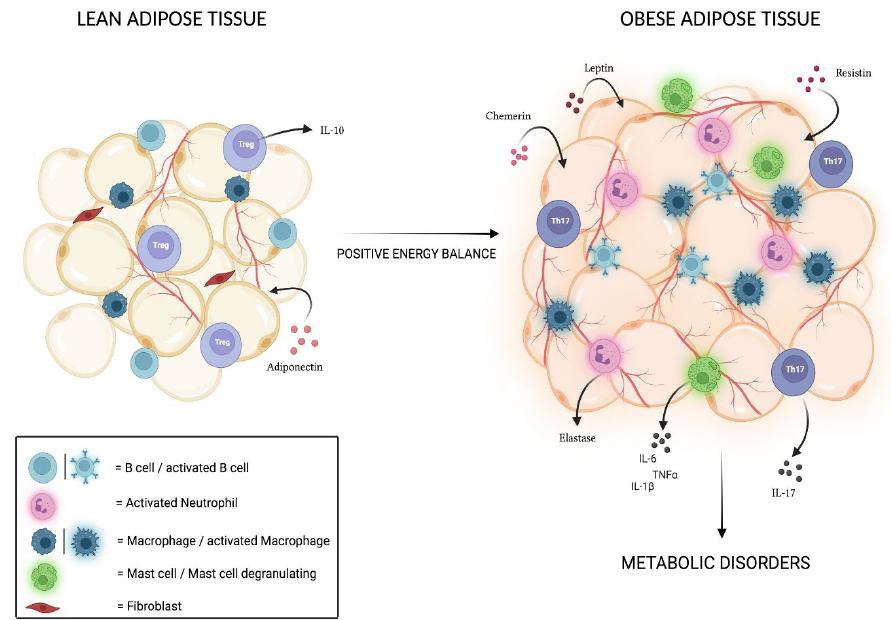
Figure 1. Immunomodulatory property of adipose tissue (created by using Biorender).